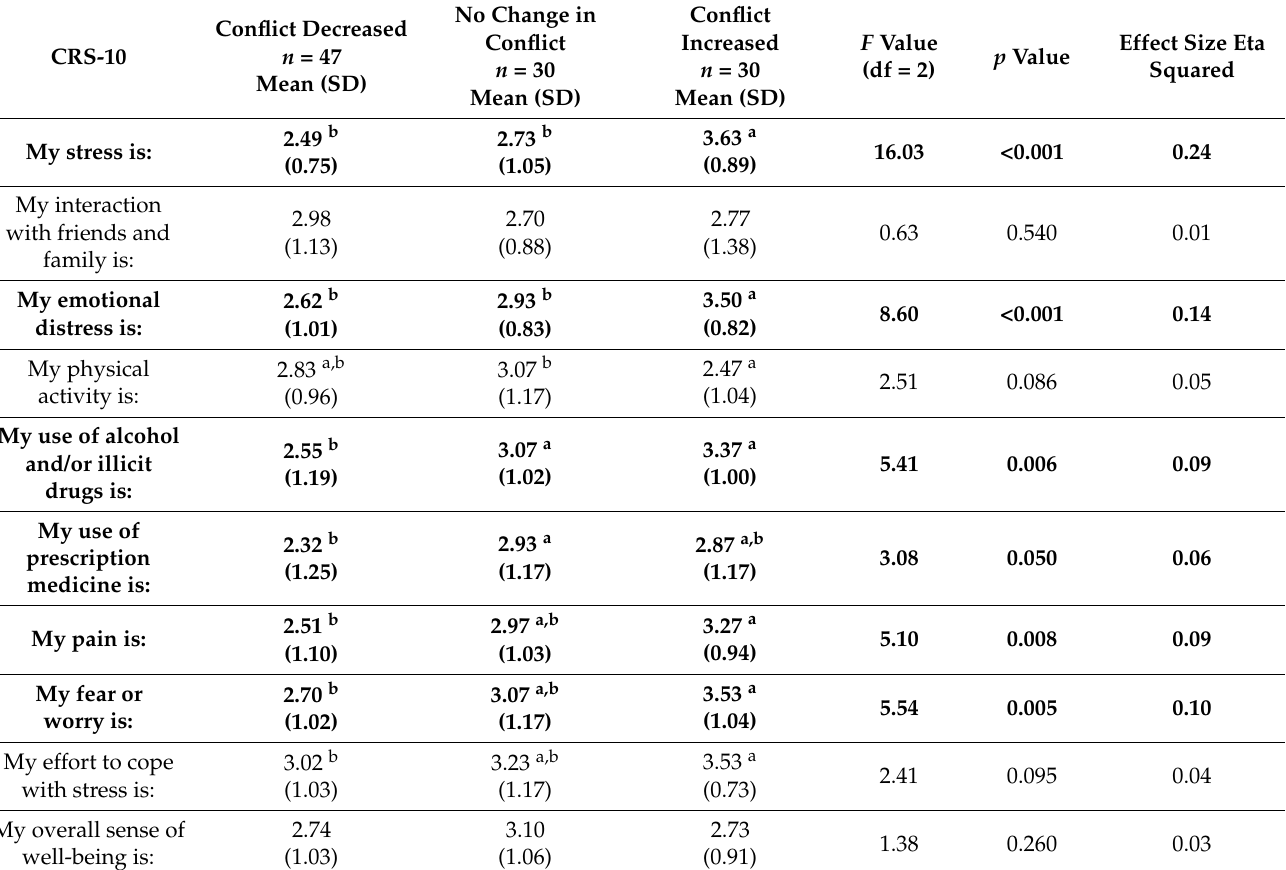
Table 3. Comparison of the three couple–conflict groups on the CRS-10 pandemic response